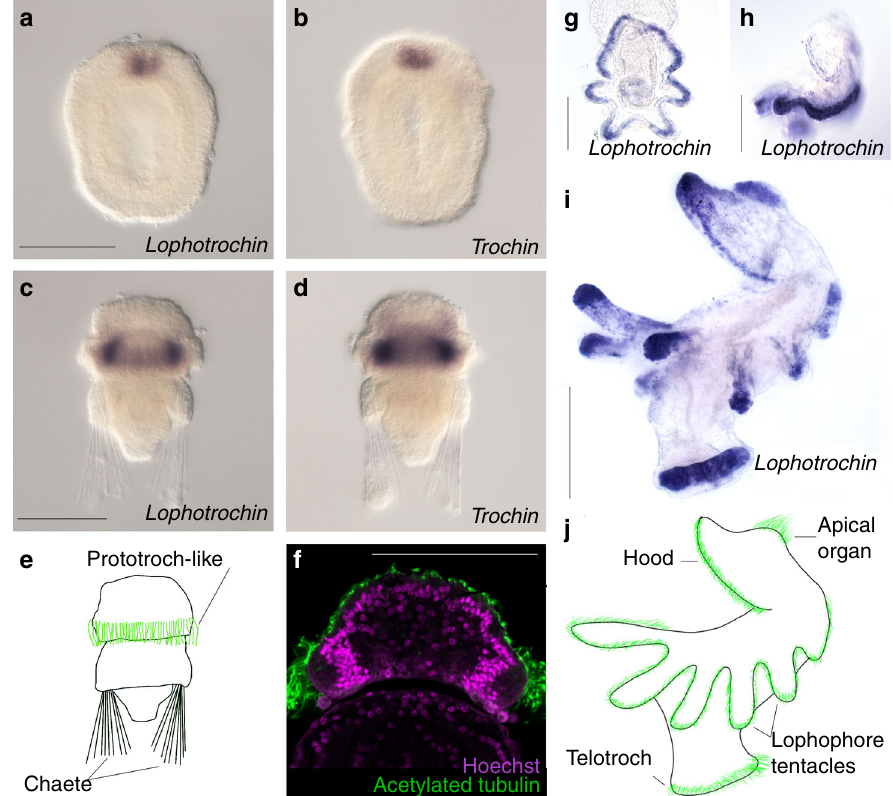
Fig. 5 Lophotrochin and trochin expression in lophophorates: brachiopods and phoronids. a – f The lophotrochin and trochin expression in brachiopod Terebratalia transversa . a Lophotrochin (purple) is expressed apically in the region where the ciliary tuft forms. b Expression of trochin (purple), also in the region where ciliary tuft forms. c In later stage larvae, lophotrochin expression is speci fi c to the ciliary band. d Expression of trochin in later larval stage is also speci fi c to the ciliary band. e Diagram of the larva, based on ( c ). Cilia are highlighted in green. f Confocal image with nuclei (magneta, Hoechst) and cilia (green, anti- acetylated tubulin) showing that the nuclei of cells underlying the prototroch-like ciliary band are deep beneath the surface, in a similar location to the in situ probe signal. Note that the ectoderm is covered with short cilia. g – j The expression of lophotrochin in phoronid Phoronopsis harmeri . g , h In Phoronopsi s ’ s four- tentacle stage larva, lophotrochin expression (purple) is observed in the telotroch and along the ciliary band spanning the larval tentacles. g posterior view, h lateral view. i Expression becomes stronger in the tentacles as development proceeds, and in the ten-tentacle stage, expression is strongest in the tips of the largest tentacles, and the telotroch, expression is also found in the ciliated cells at the edge of the preoral lobe (or hood) and in the apical organ. j Diagram of the actinotroch larva showing ciliary structures (apical organ, edge of the preoral lobe, the main ciliary band spanning lophophore tentacles, and telotroch) highlighted in green. Scale bars: 100 μ m. For each in situ hybridization, at least 20 animals were stained and all had the pattern